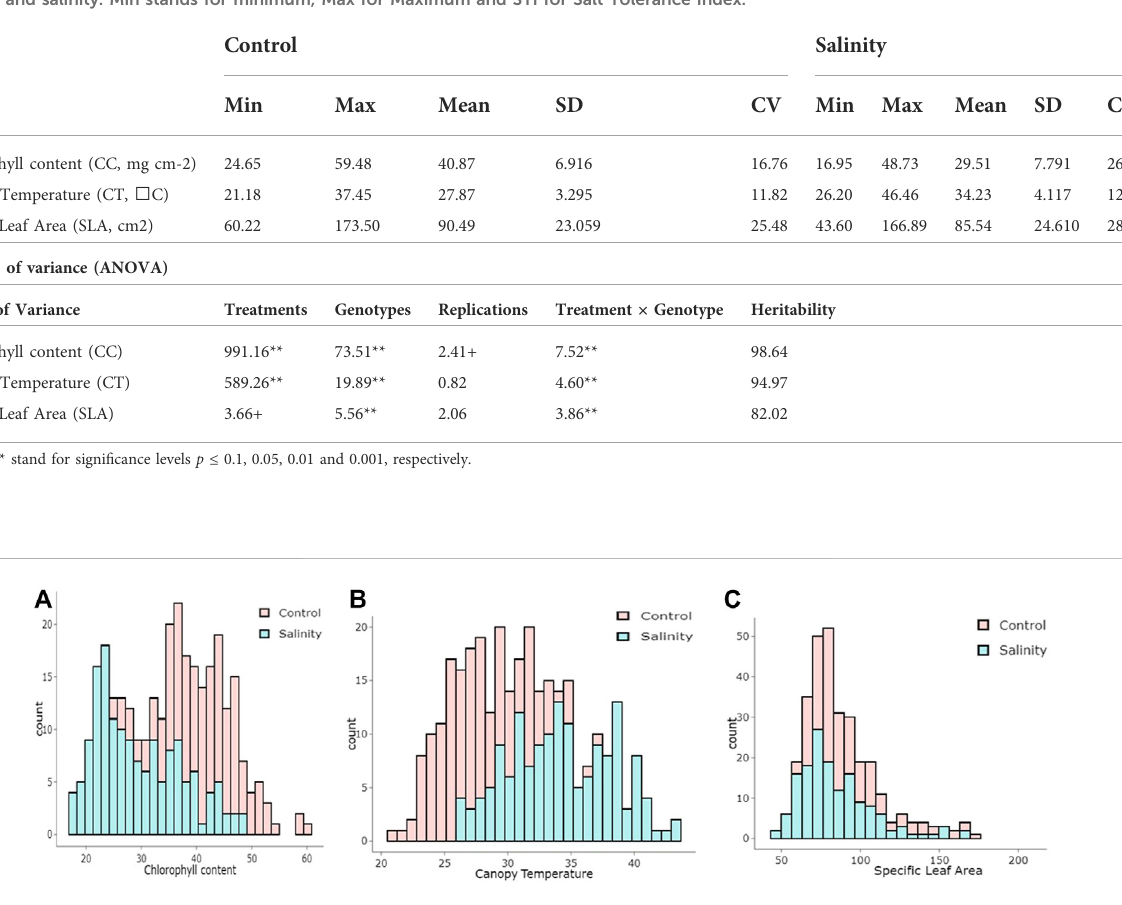
FIGURE 1 Histogramillustratingthedistributionof (A) chlorophyllcontent(CC,mgcm-2), (B) canopytemperature (C) andspeci fi cleafarea(cm2)inwheat under control and salinity